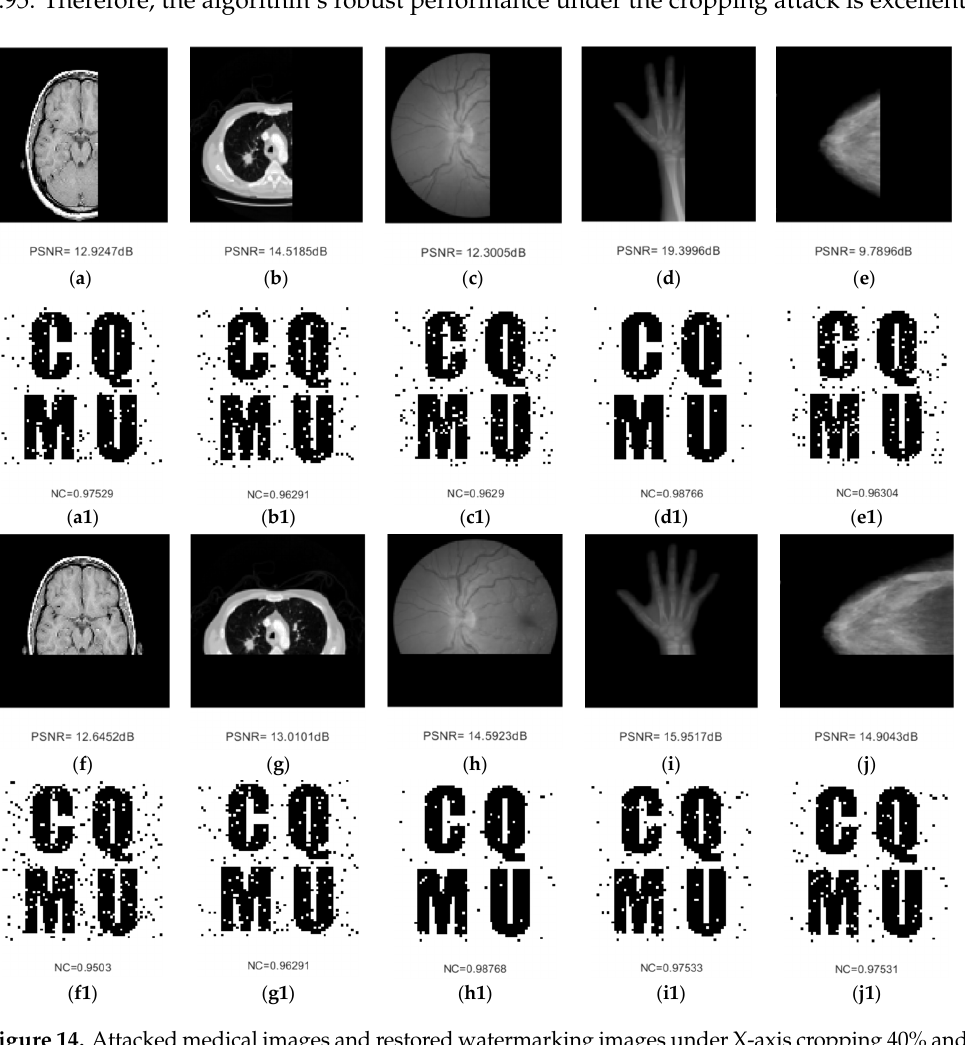
Table 5. The result under scaling attacks.